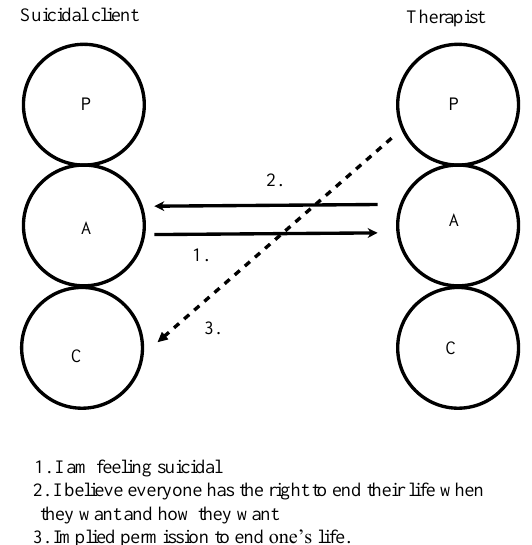
Figure 4: Permission to choose The client has suicidal urges and the therapist